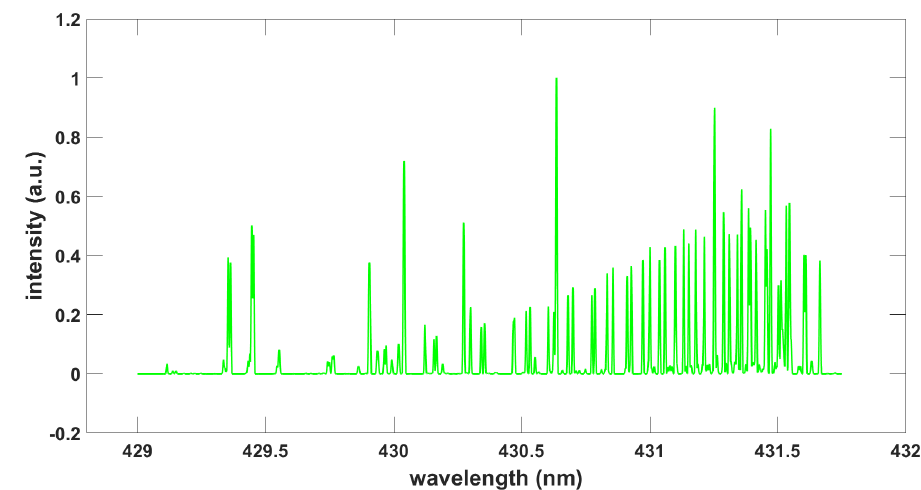
Figure 4. Computed CH A − X emission spectrum, δ λ = 0.005nm, T = 1.5 kK.